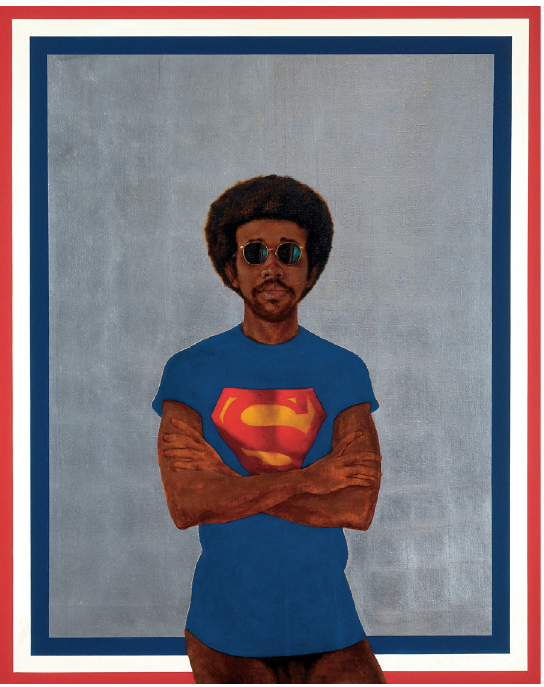
Figure 2. Hendricks, Barkley L., Icon for My Superman , ( Superman Never Saved Any Black People—Bobby Seale ) (1969). Oil, acrylic, and aluminium leaf on linen canvas, 59 1/2 x 48 in. ©Estate of Barkley L. Hendricks. Courtesy of Jack Shainman Gallery, New